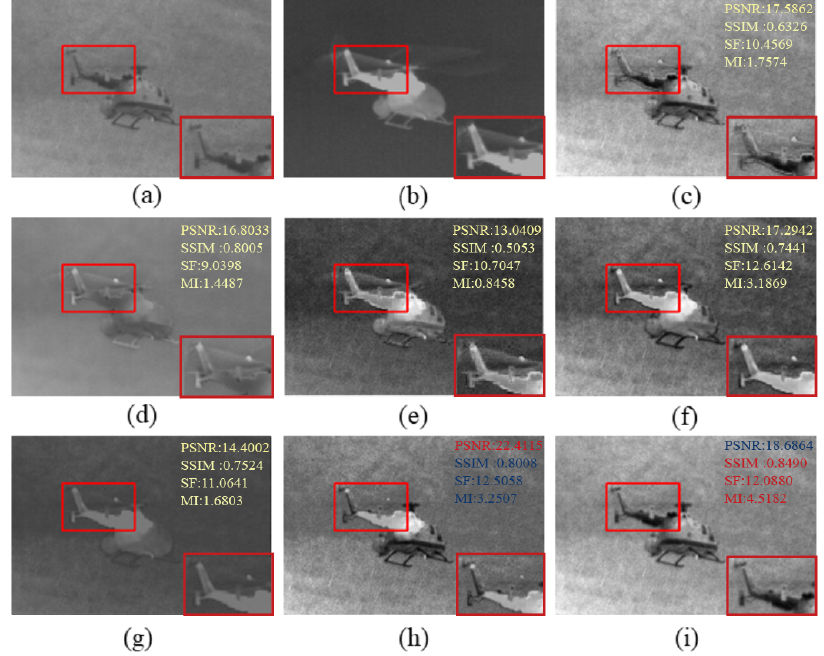
Figure 2. Qualitative comparison of LCF with six state-of-the-art methods on a helicopter. For a clear comparison, we select a salient region (i.e., the red box) in each image and enlarge it in the bottom right corner. In addition, the evaluation indicators are displayed on the top right, with red representing the best and blue the second best. ( a ) Visible image; ( b ) Infrared image; ( c ) LP; ( d ) GTF;